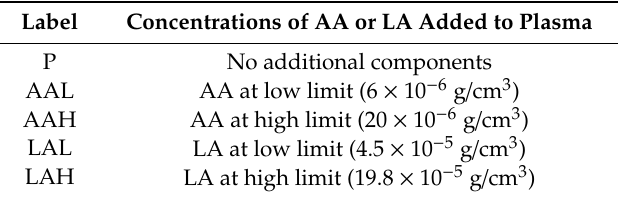
Table 1. Solutions sets used in the study. AA: ascorbic acid, LA: lactic acid.